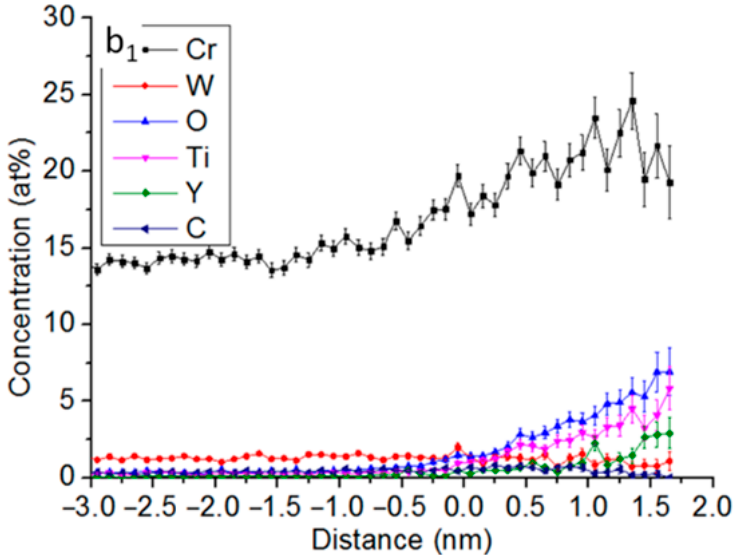
Figure 7. Ti interfaces and Cr interfaces defined by isoconcentration surfaces of 1.0 to 2.0 at% Ti and 18 to 22 at% Cr in 14YWT, and the corresponding proxigram showing variation in composition as a function of distance from an 18% Cr isoconcentration surface in 14YWT alloy ( a ) before heavy ion irradiation and ( b ) after heavy ion irradiation to 100 dpa at 700 ◦ C. (( a1 ) is the corresponding proxigram of 18% Cr isoconcentration surface in 14YWT alloy without heavy ion irradiation, ( b1 ) is the corresponding proxigram of 18% Cr isoconcentration surface in 14YWT alloy with heavy ion irra- diation).